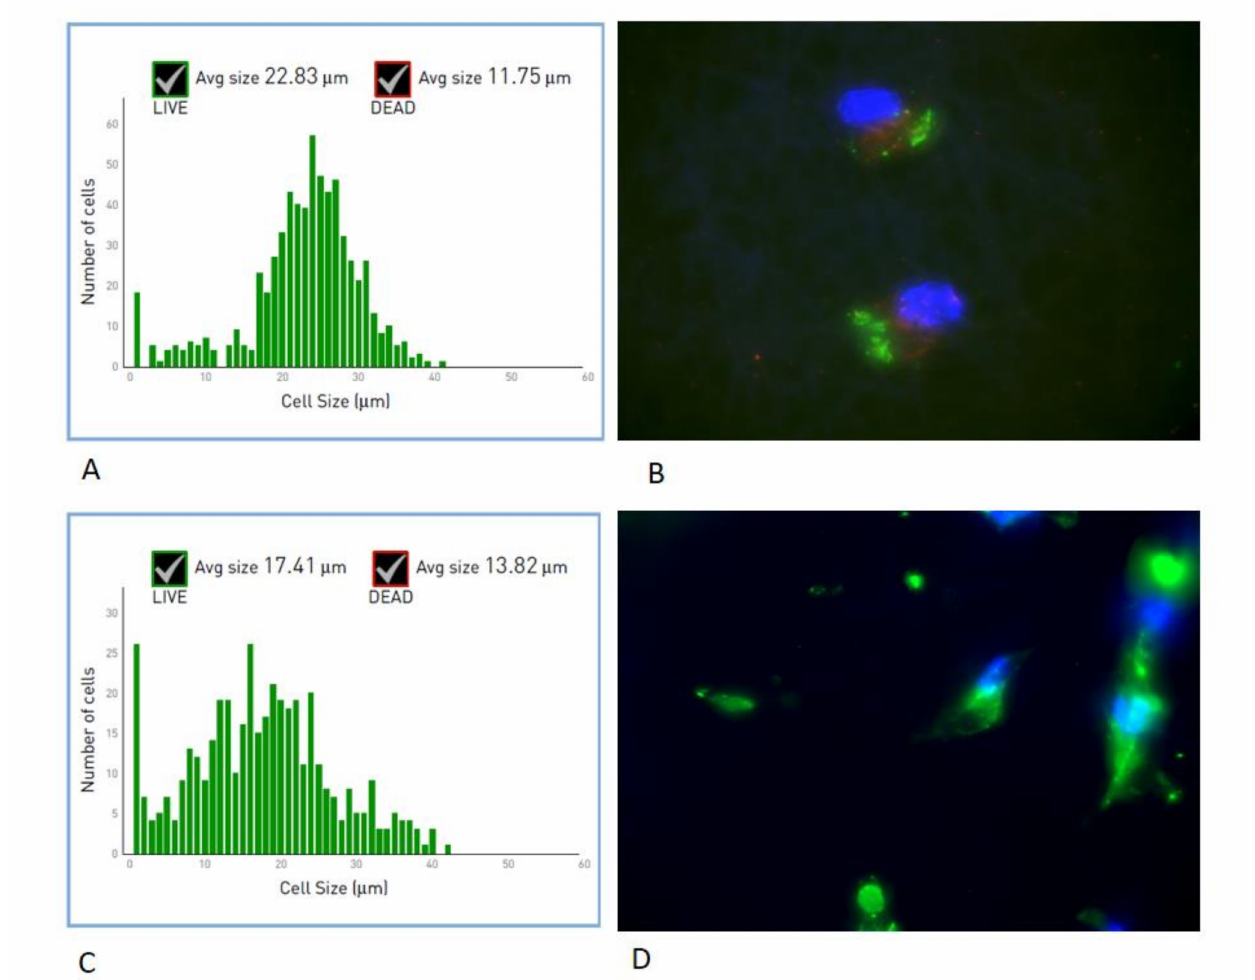
Figure 2. Morphological analyses of endothelial cells ( A , B ) and fibroblast ( C , D ) after seeding on the electrospun fibers. ( A , C ) are related to the size of the cells, ( B ) related to CD31 (green) and wV (red) markers of mature endothelial cells; ( D ) related to phosphatase (green) marker of